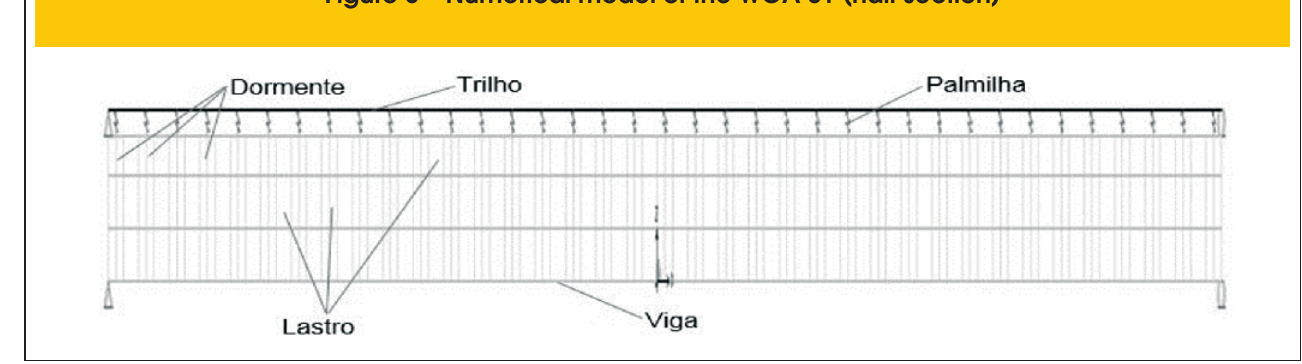
Figure 3 – Numerical model of the WOA 01 (half